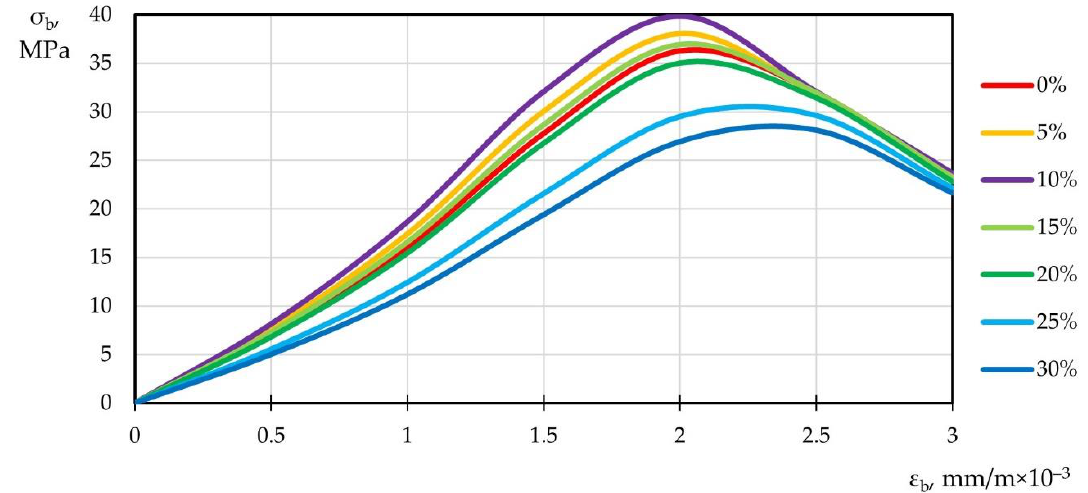
Figure 7. Stress–strain diagram in Figure 7. Stress – strain diagram in compression.